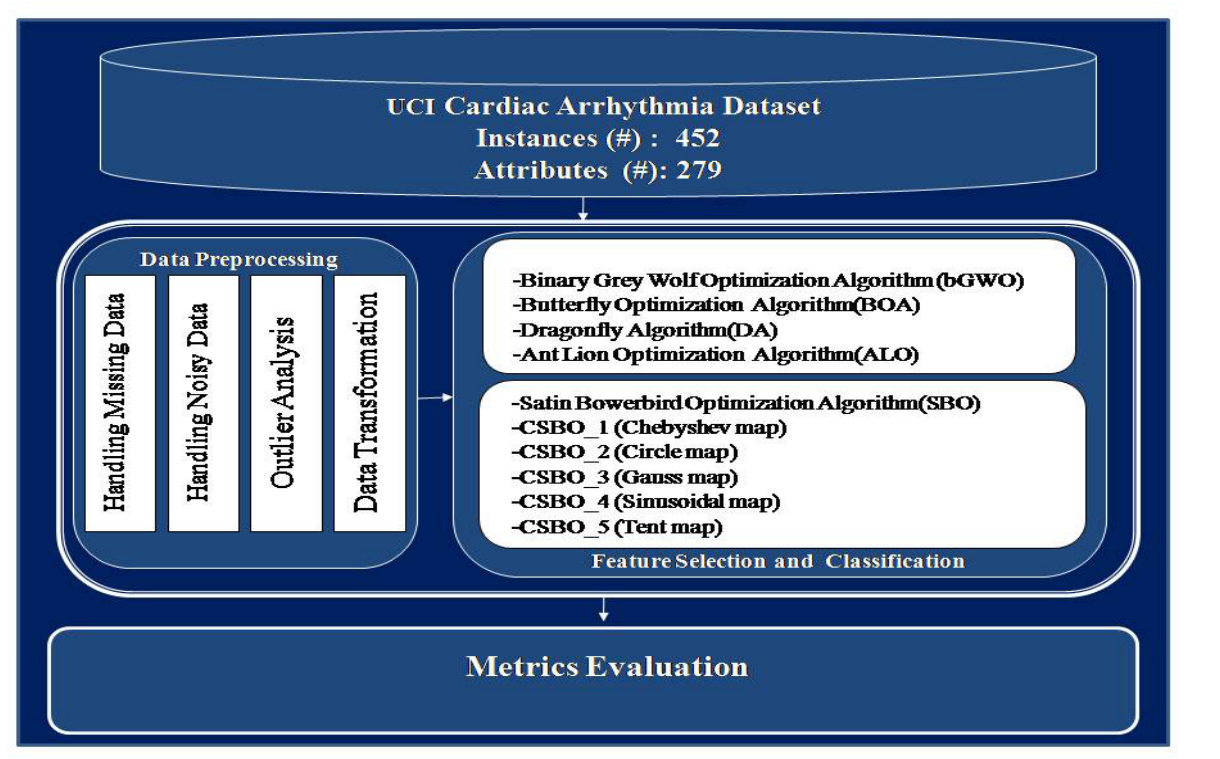
Figure 1. Manuscript